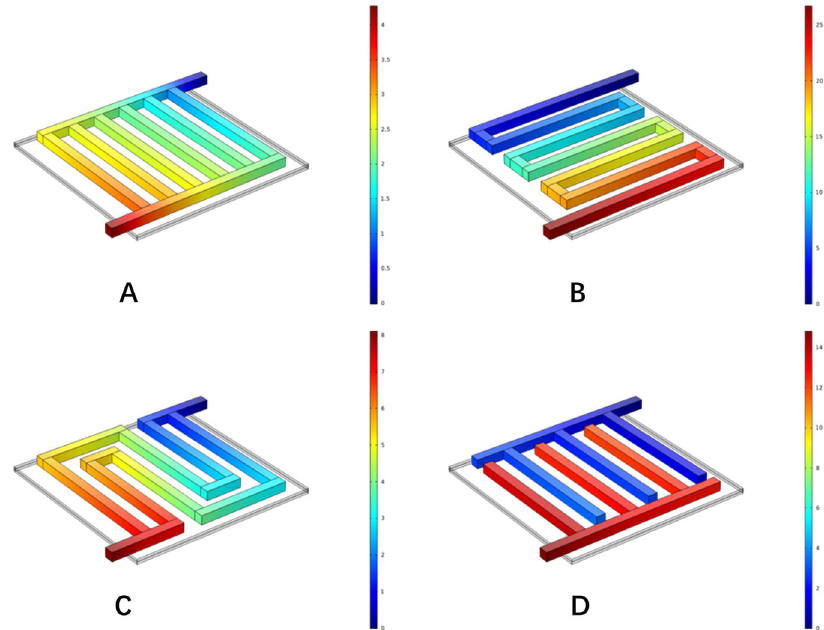
Figure 9. Pressure distribution in microchannels with different flow fields. ( A ) Parallel, ( B ) serpen ‐ tine, ( C ) multi ‐ serpentine, and ( D ) interdigitate. ( C ) multi-serpentine, and ( D )